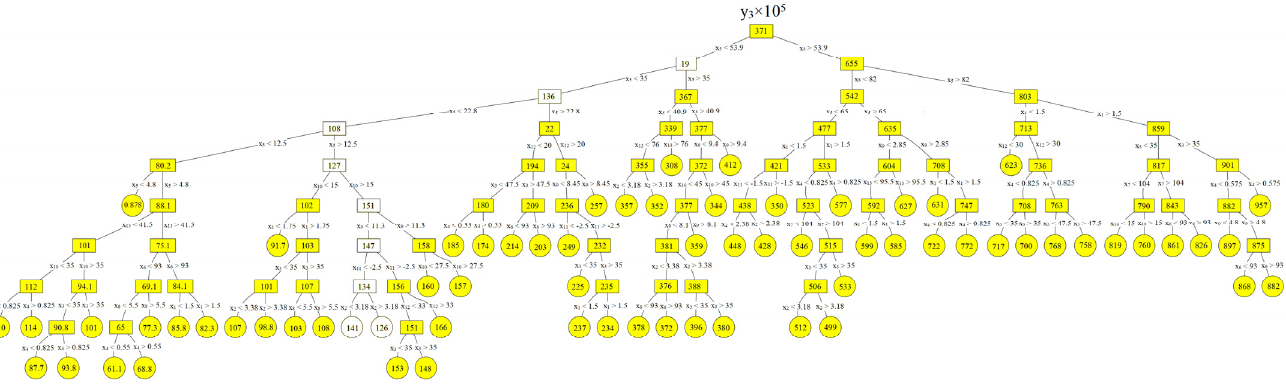
Figure 6. Regression tree analyzing the dependence of the crystal growth rate y 2 (mm/h) on the furnace design and process parameters x 1 –x 13 . The white-marked branches where leaf nodes have a maximum mean y 2 value are favorable. The RMSE for each split is given in Table A2 in Appendix A. Table 3. The most decisive inputs and their optimal values for the Cz-Ge growth with high growth rate y 2 , derived from RT analysis. The data ranges correspond to the white nodes in Figure 6.